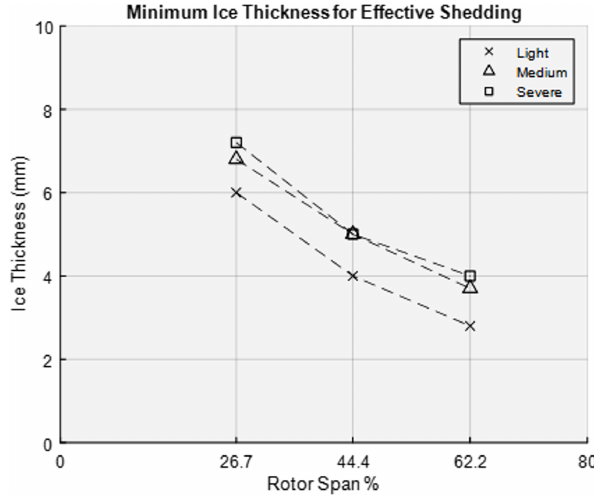
Figure 20. Minimum ice thicknesses needed for effective shedding.